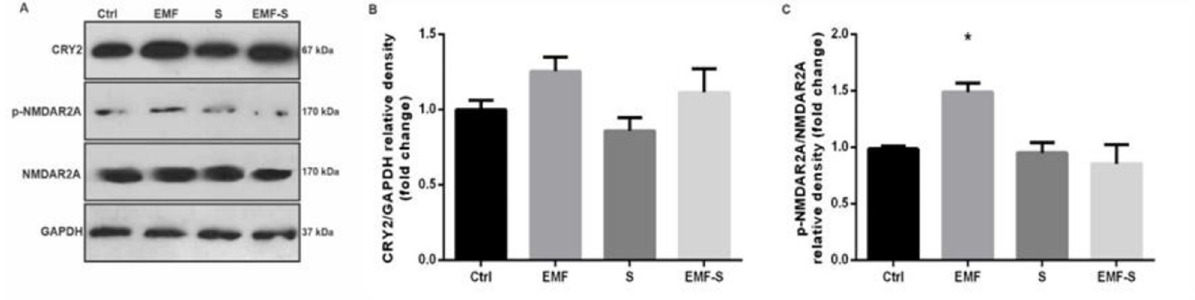
Fig 3. Effect of EMF on cryptochrome 2(cry2) and N-Methyl-D-Aspartate receptor 2(NMDAr2) / phosphorylated N-Methyl-D-Aspartate receptor2 (PNMDAr2) after prenatal stress. A representative immunoblotting image of cry2, NMDAr2, PNMDAr2 and GAPDH in different groups (A). Graphs show the protein expression of cry2 (B) and NMDAr2/ PNMDAr2 (C). Data are shown as mean ± SEM (n = 6 per group). Two-way ANOVA, followed by Tukey’s posthoc test: � p < 0.05 versus control group; ANOVA, analysis of variance; Ctrl, Control; EMF, Electromagnetic Field; S, Stress.